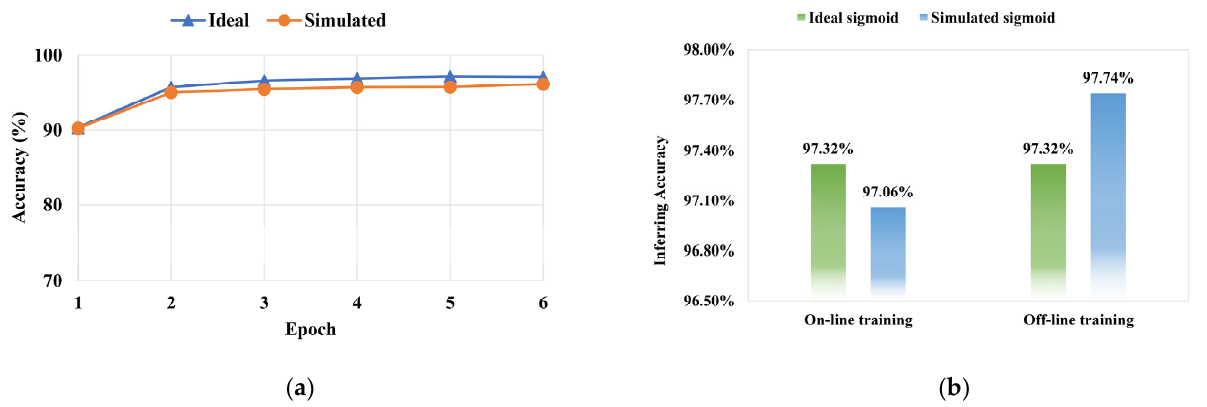
Figure 9. ( a ) Measured the training accuracy of recognition in the MNIST training dataset, with the ideal sigmoid and with the simulated sigmoid. ( b ) Measured the inference accuracy of recognition in the MNIST test dataset, with the ideal sigmoid and with the simulated sigmoid, setting epoch = 6.